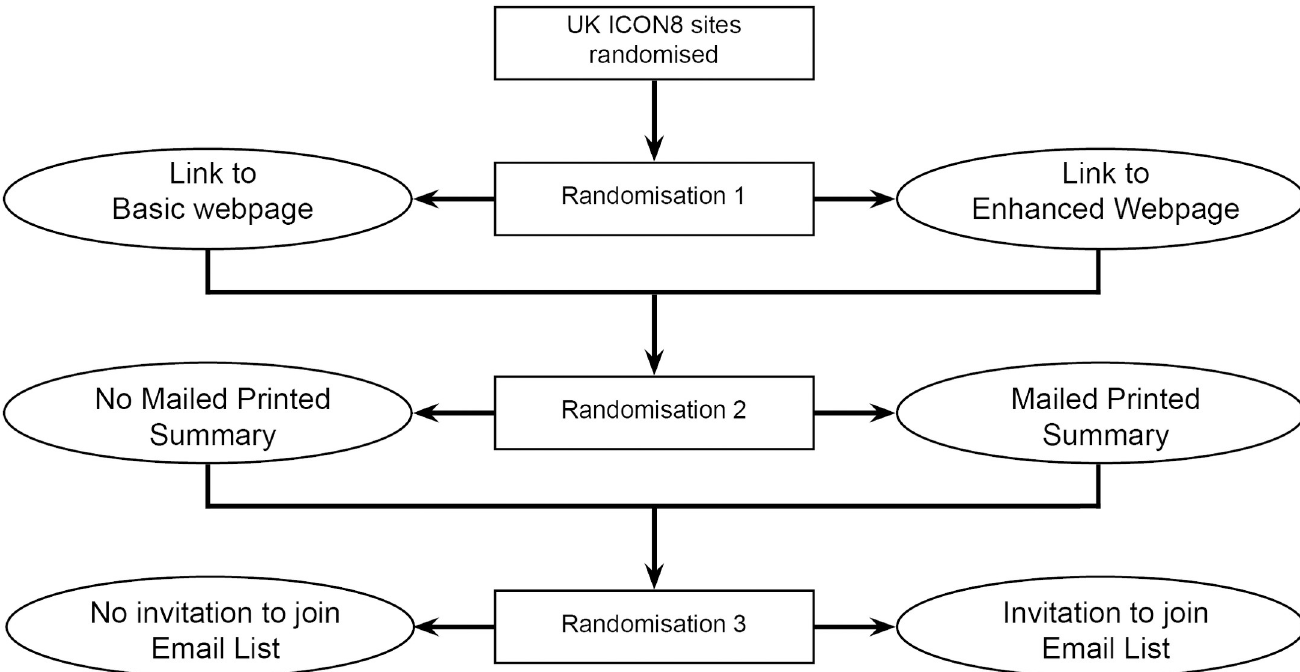
Fig 1. Show RESPECT trial schema. Diagram showing the 3 randomisations within Show RESPECT: (1) Link to Basic Webpage or Enhanced Webpage; (2) No Mailed Printed Summary or Mailed Printed Summary; and (3) No invitation to join Email List or Invitation to join Email List.